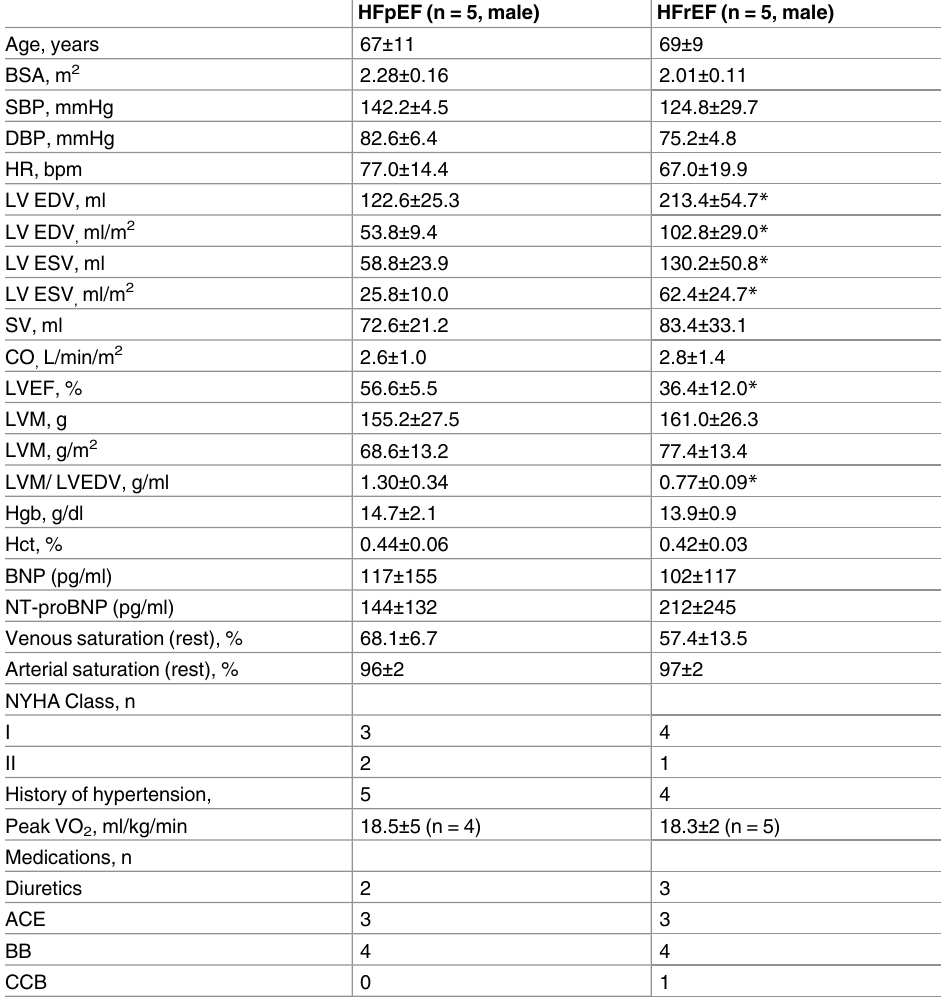
Table 1. Participant